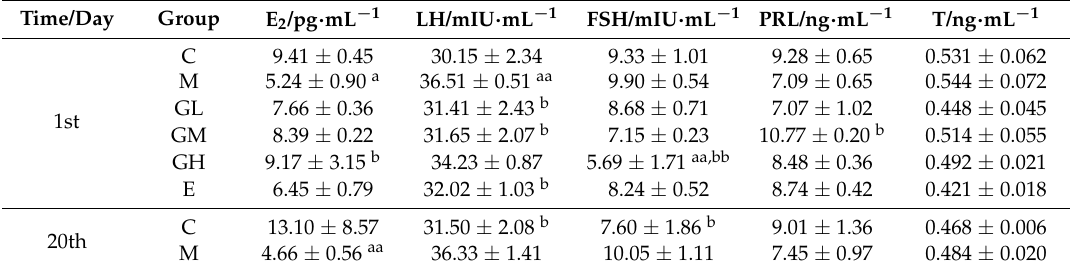
Table 1. Levels of sex hormone in mouse serum.